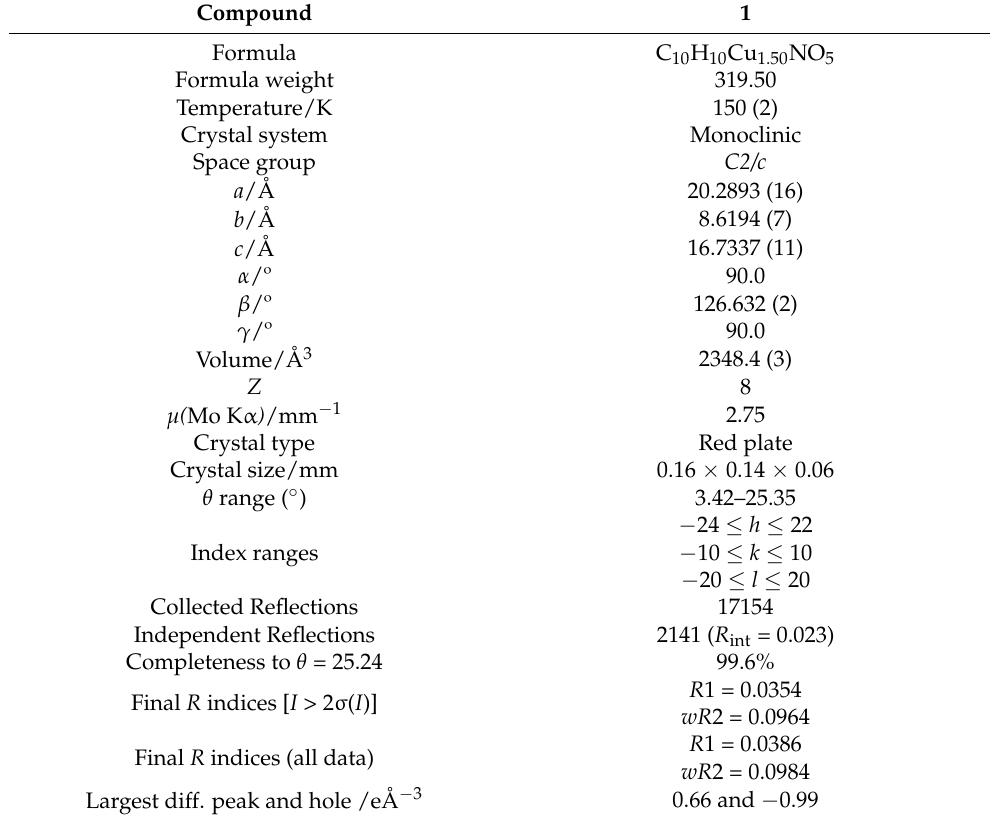
Table 2. Crystallographic data and structure refinement details of compound 1